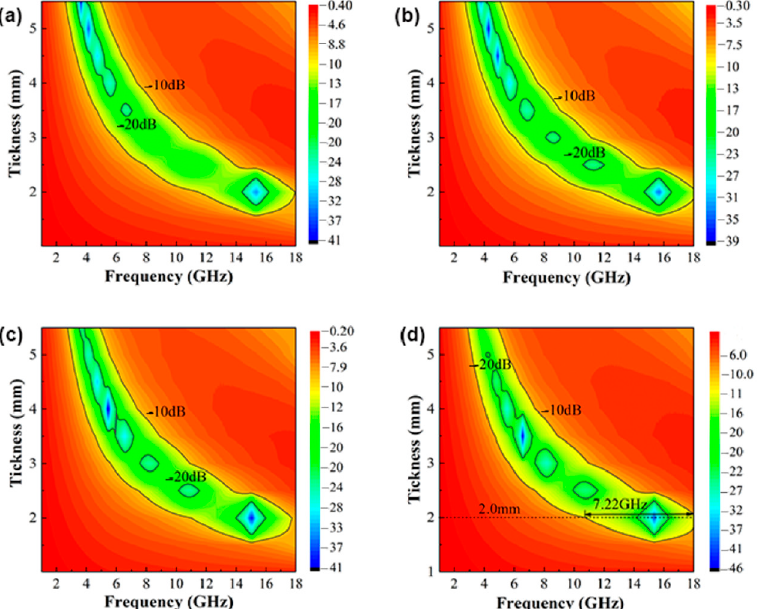
Figure 11. Contour diagram of reflection loss of Fe 73.2 Si 16.2 B 6.6 Nb 3 Cu 1 nanocrystalline alloy powder